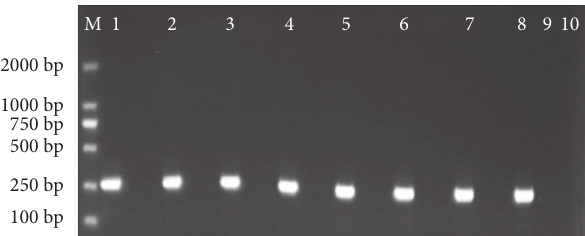
Figure 4: The PCR test for genomic DNA reference materials of no. 1–8. M , DNA marker D (100 ∼ 2000bp); lanes 1–8, PCR results of no. 1–8, respectively; lane 9, negative control; and lane 10, blank